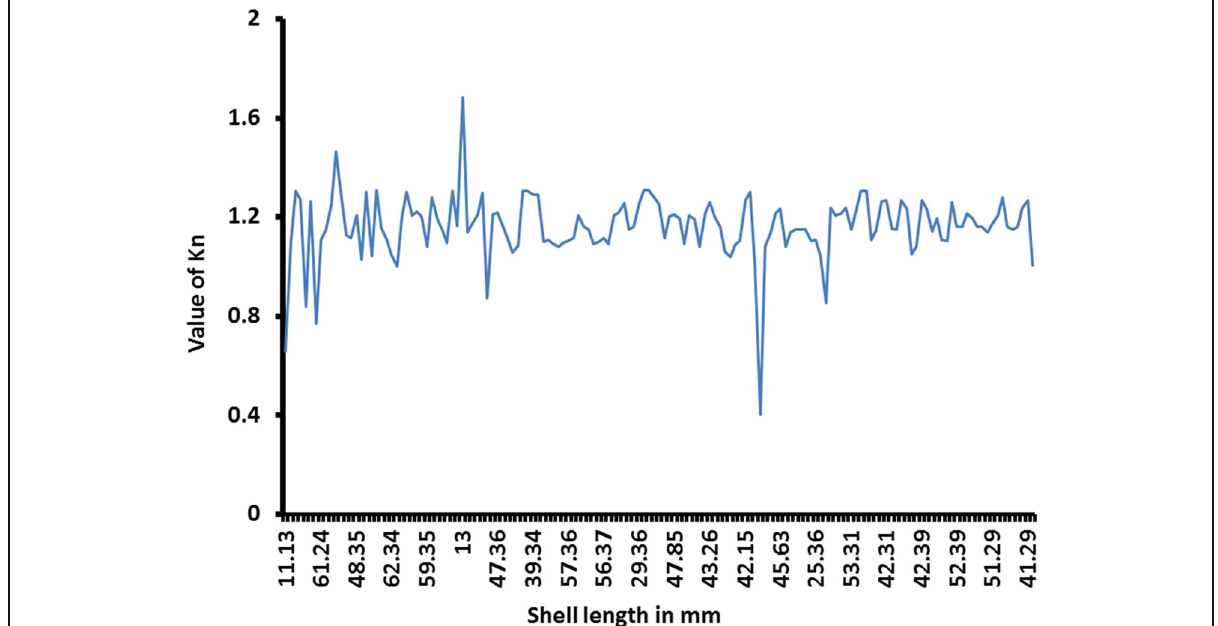
Fig. 6 Relationship between shell length and value of relative condition factor K n